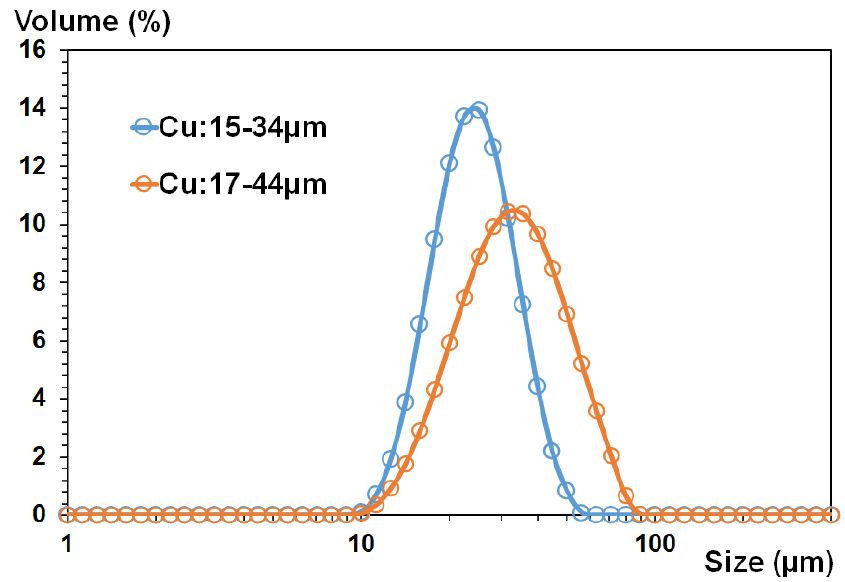
Figure 1. Size distributions of the Cu powders: 17 – 44 µm sized powders, and 15 – 33 µm sized pow- ders.